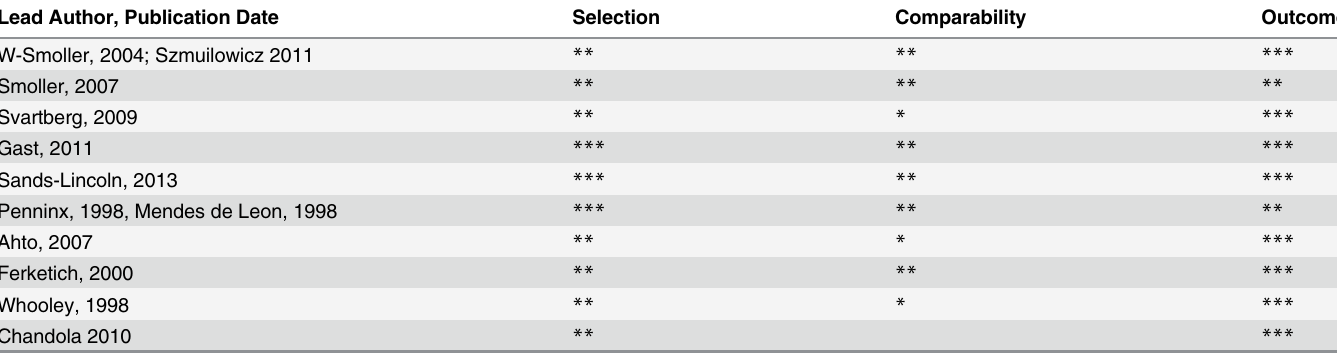
Table 2. Assessment of study quality through the Newcastle-Ottawa